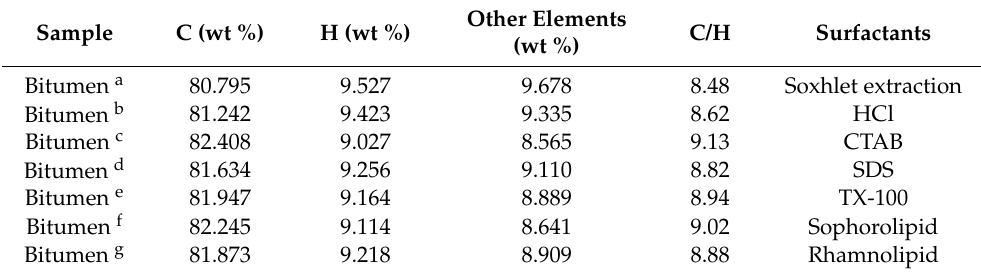
Table 3. Element analysis of seven different bitumen